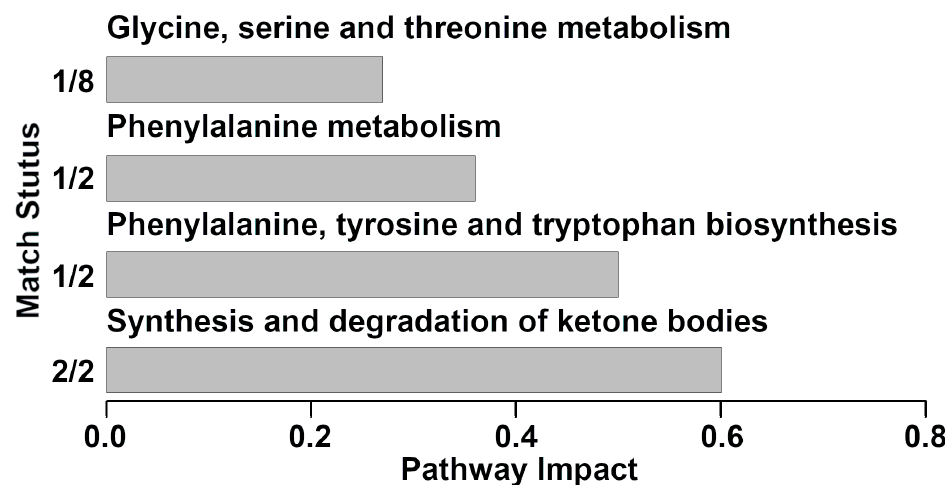
Figure 4. Metabolic pathways evidenced by enrichment analysis based on the statistically significant metabolites quantified from serum samples between different groups (impact value > 0.2).